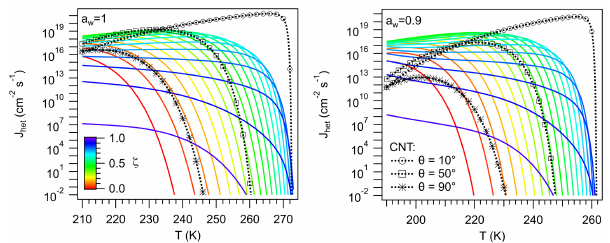
Figure 6. Ice nucleation rate calculated using Eq. (61) for differ- ent values of ζ (color). Black lines were calculated using CNT for different values of the contact angle, θ